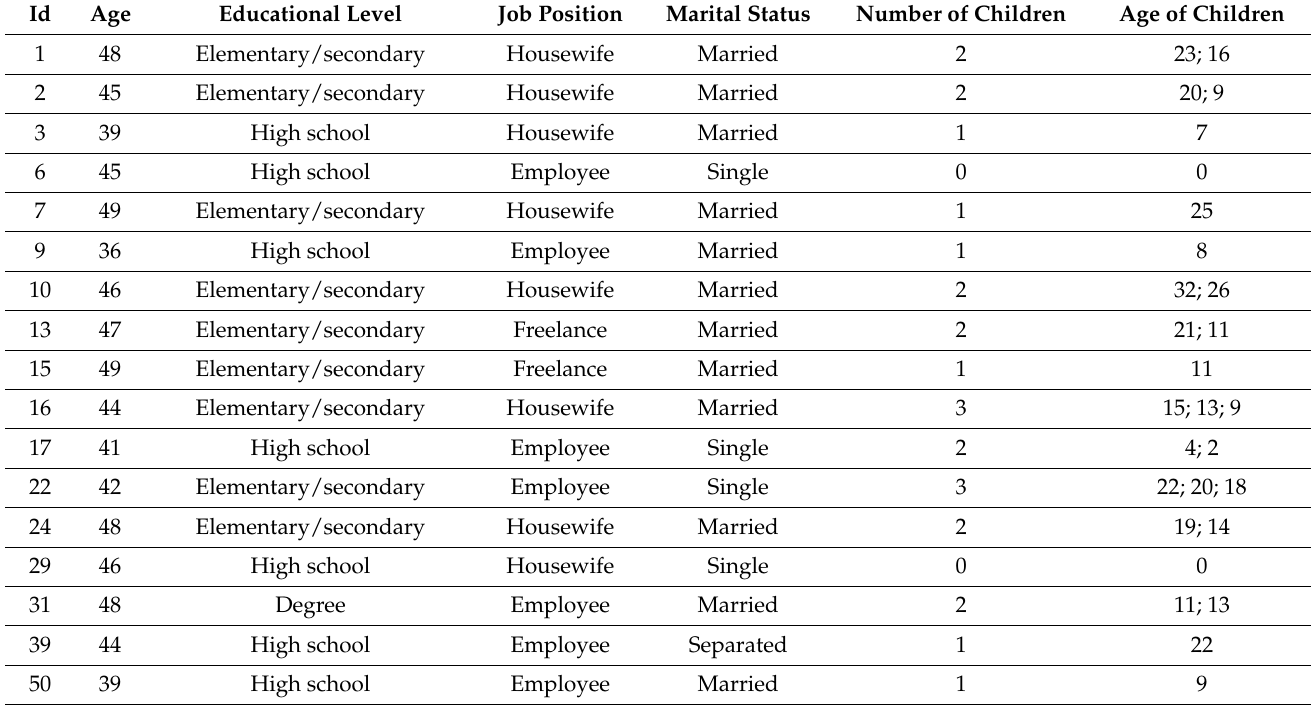
Table 1. Sociodemographic characteristics of the breast cancer women participated in the